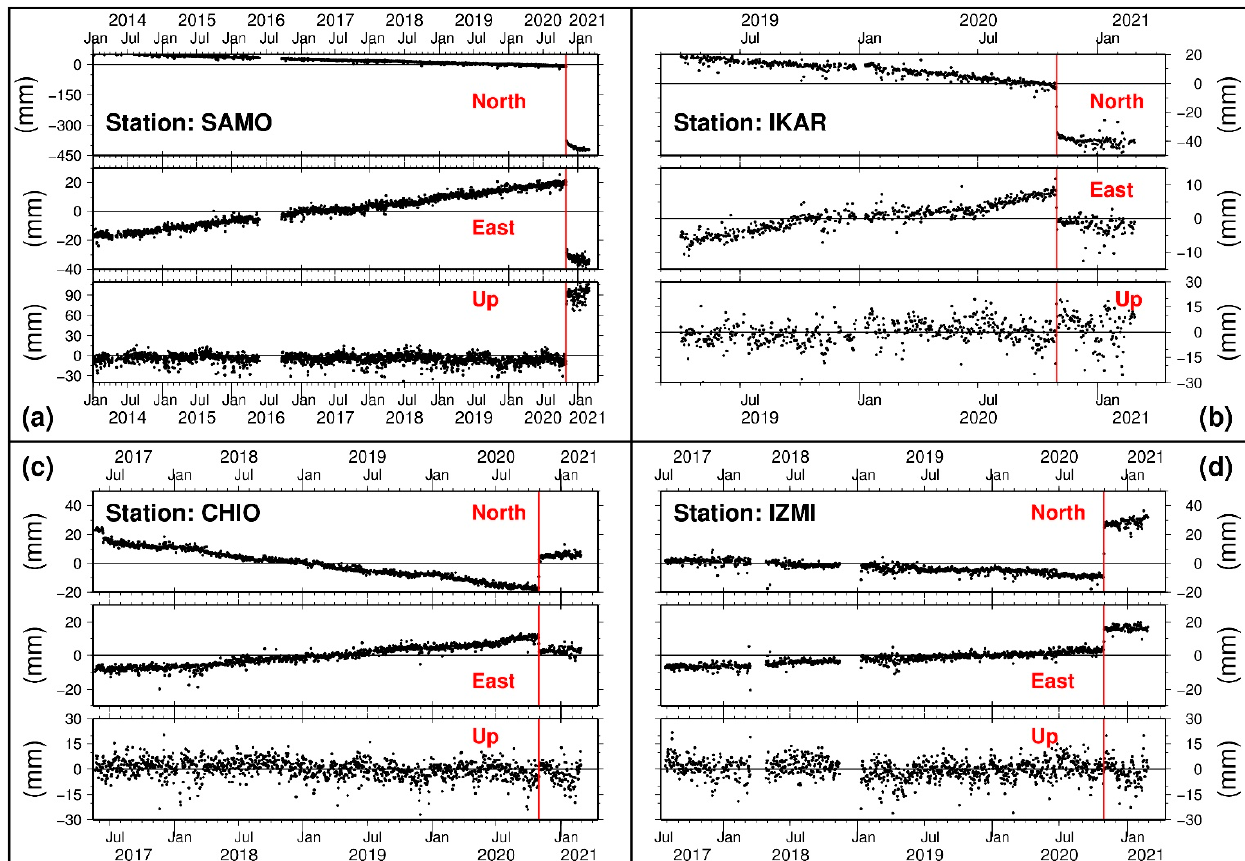
Figure 3. Time series of four GNSS stations: ( a ) SAMO, ( b ) IKAR, ( c ) CHIO, and ( d ) IZMI. Red line marks the day of the earthquake. The reference frame is ITRF2014.